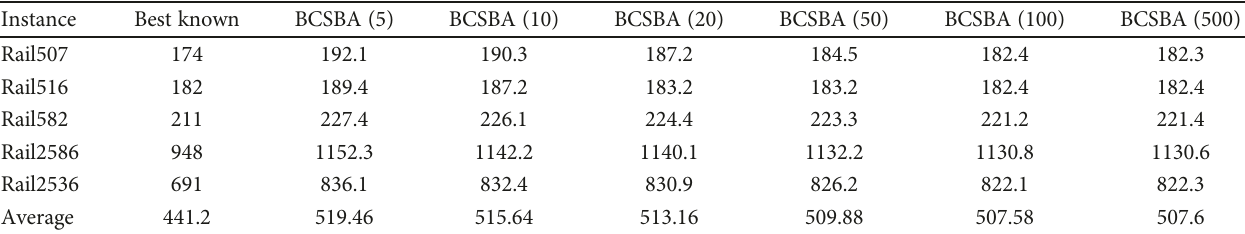
Table 4: Average result by problem type for railway scheduling dataset.